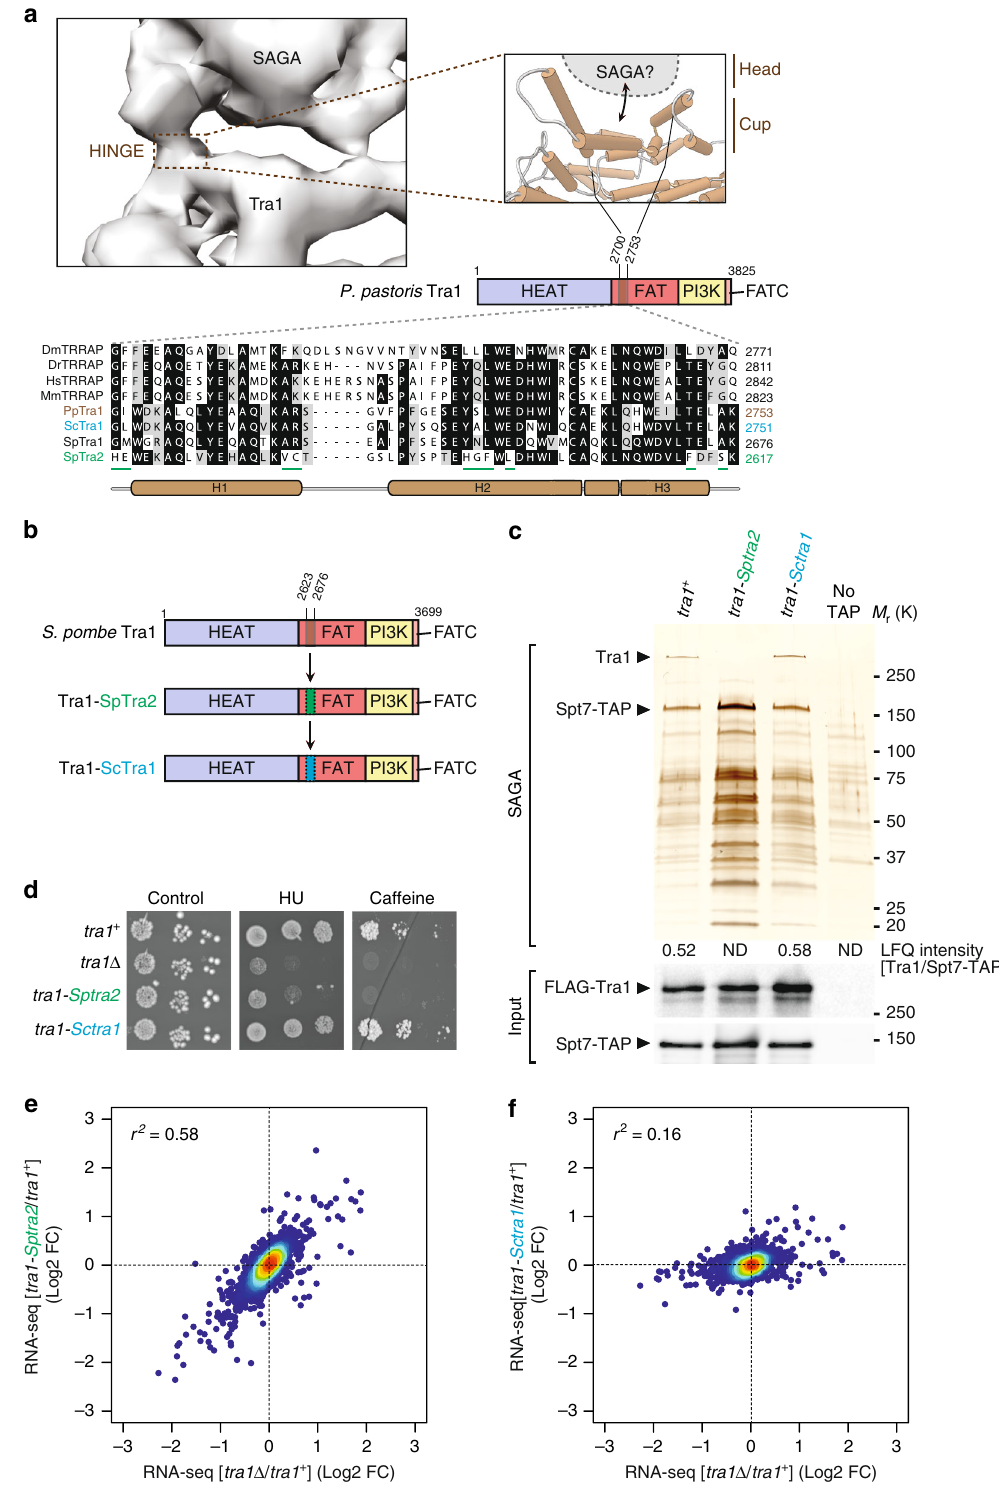
each mutant is still present in SAGA (Fig. 7d). Finally, secondary structure prediction identi fi ed a α -helix in this region (Fig. 7a), further arguing that the Spt20 HIT region